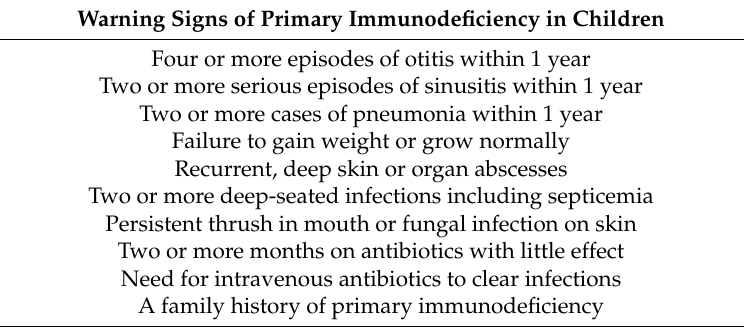
Table 4. Warning signs of primary immunodeficiency in